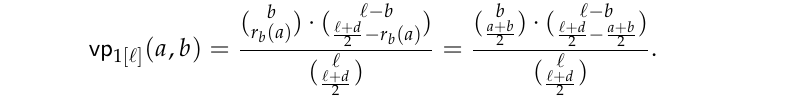
paths ( a , b ) in purple for the prism (cid:108)